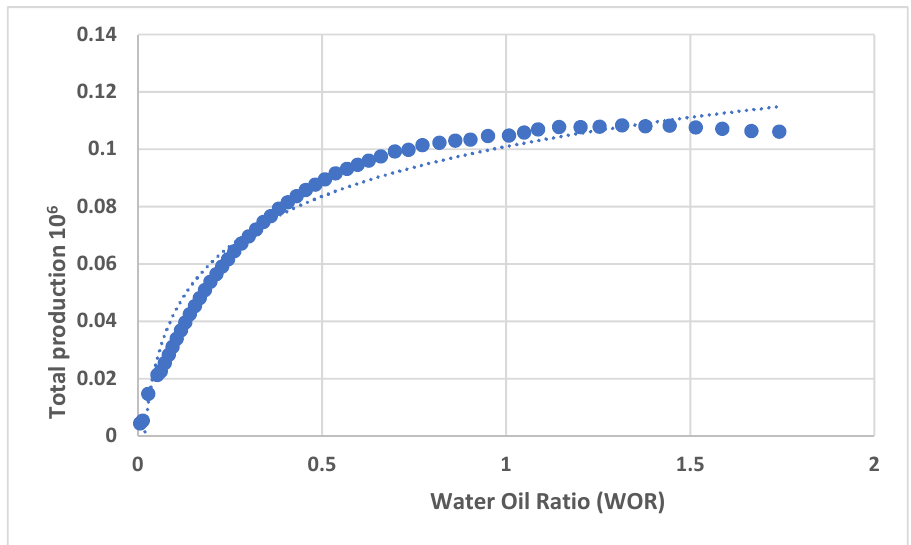
Figure 16. Total production versus water–oil ratio (WOR).